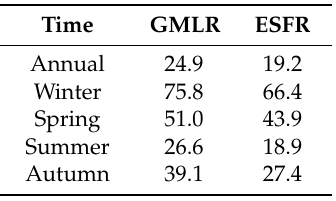
Table 9. Annual and seasonal model cross validation